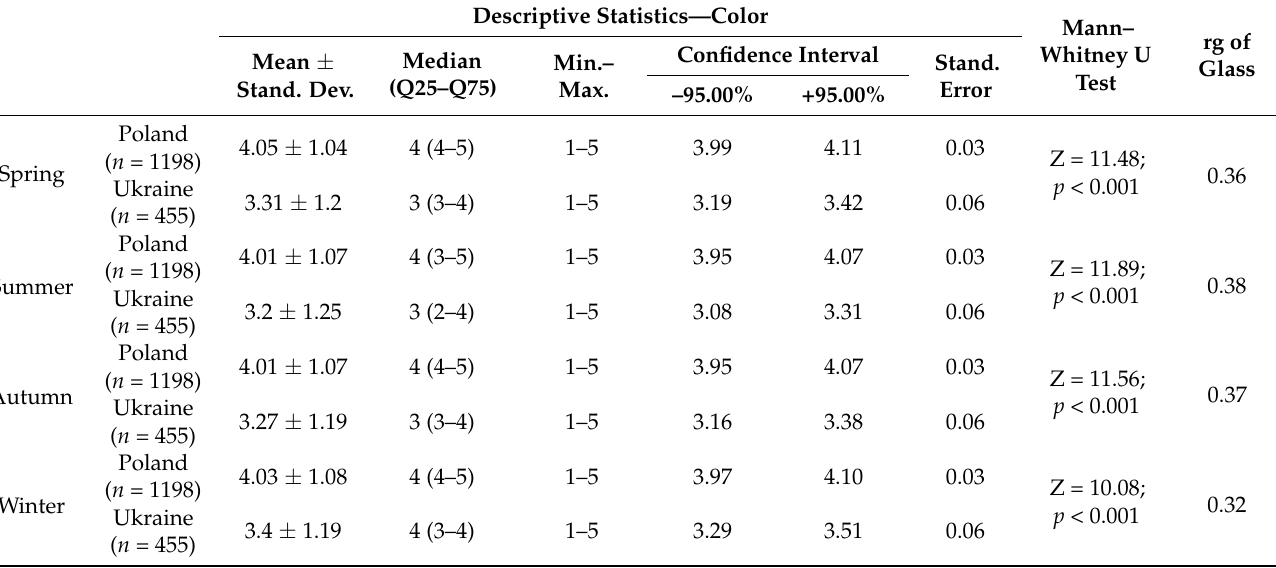
Confidence Interval Min.– Max.